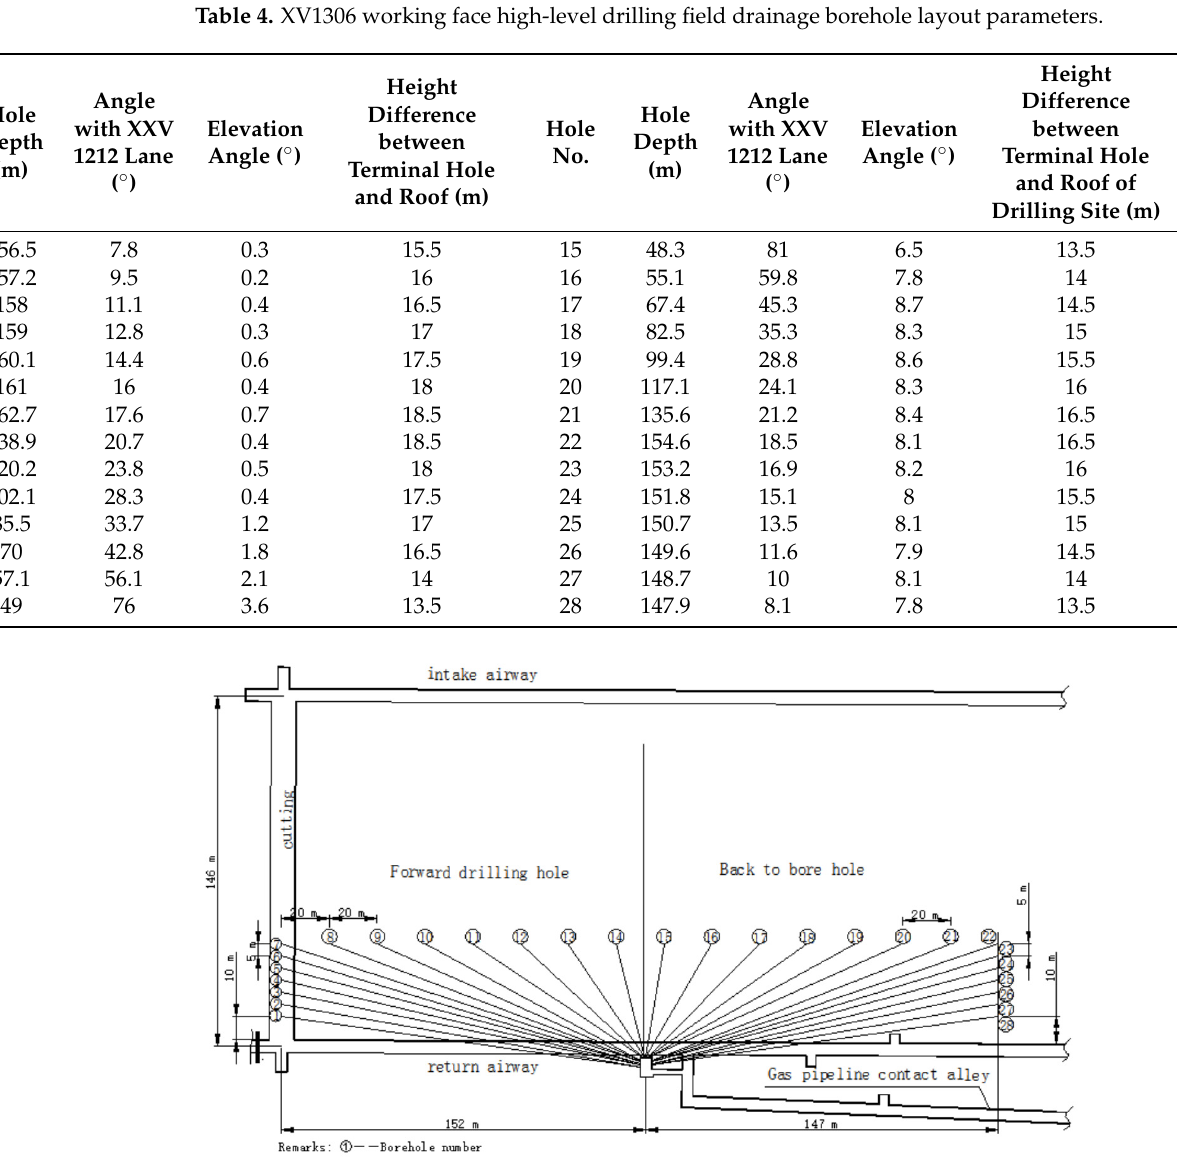
Table 4. XV1306 working face high ‐ level drilling field drainage borehole layout parameters.